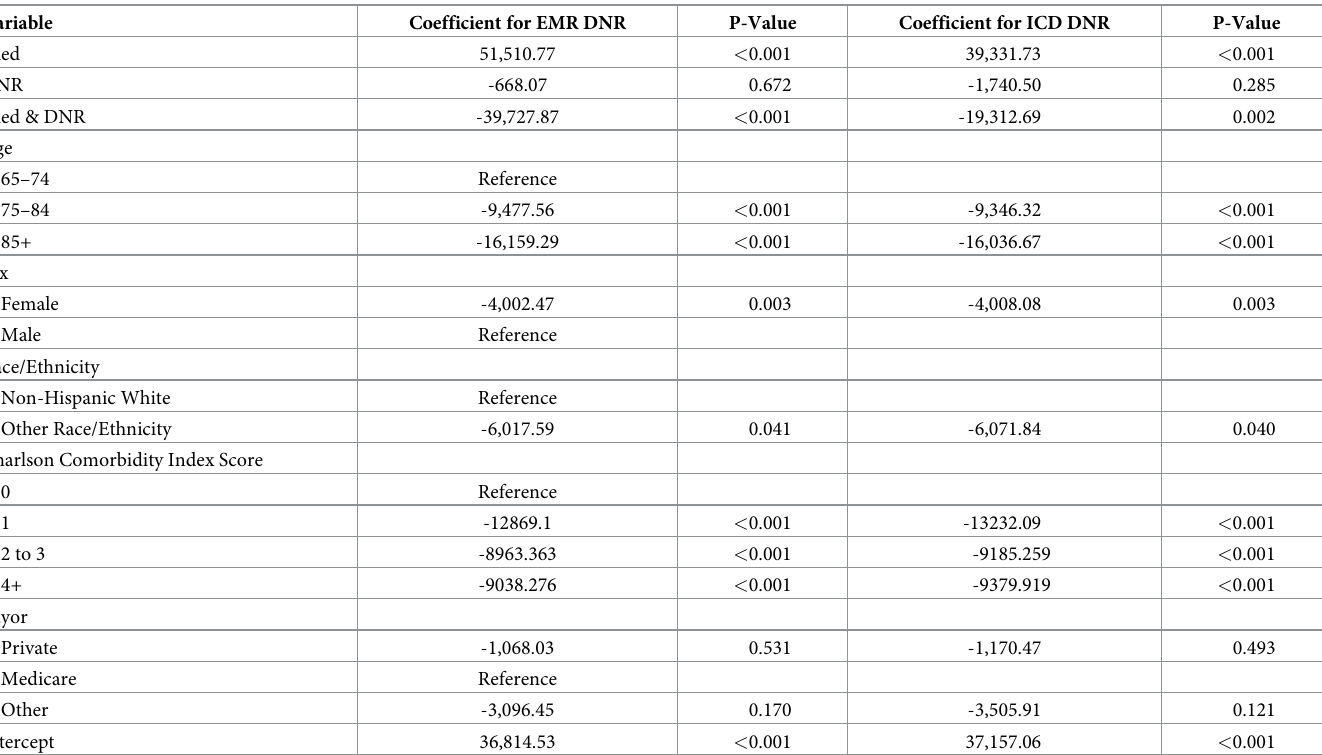
Table 5. Results of linear regression models of hospital cost controlling for eDNR versus iDNR as independent variables as well as other